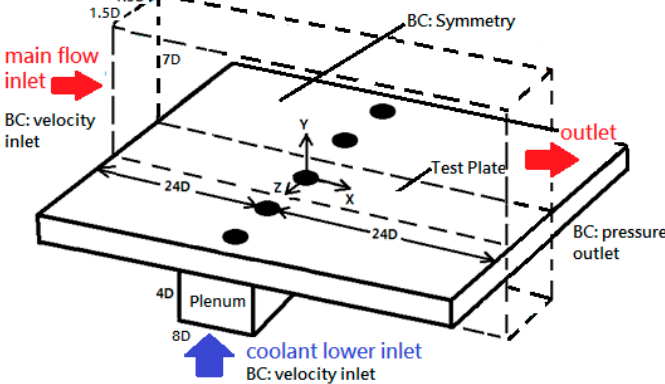
Figure 5. The schematic of the computational domain for LES (Large eddy simulation) and DES (Detached eddy simulation) calculations for the Seo et al. [7] case.